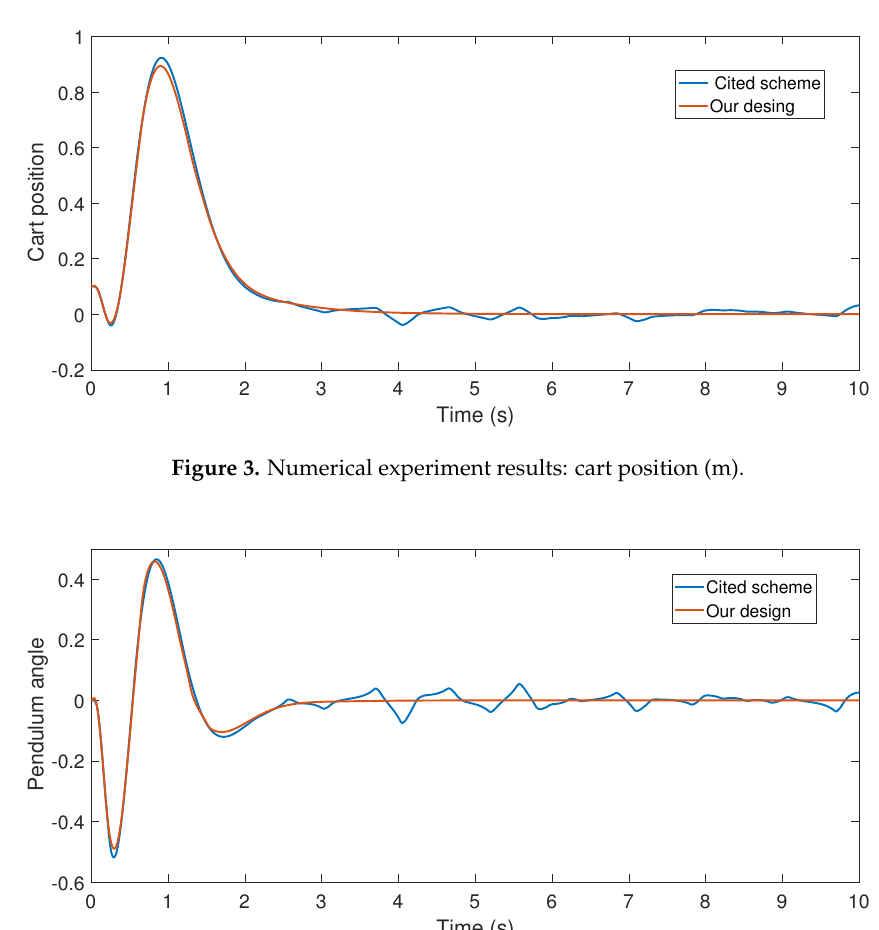
Figure 2. Inverted pendulum on a cart system.